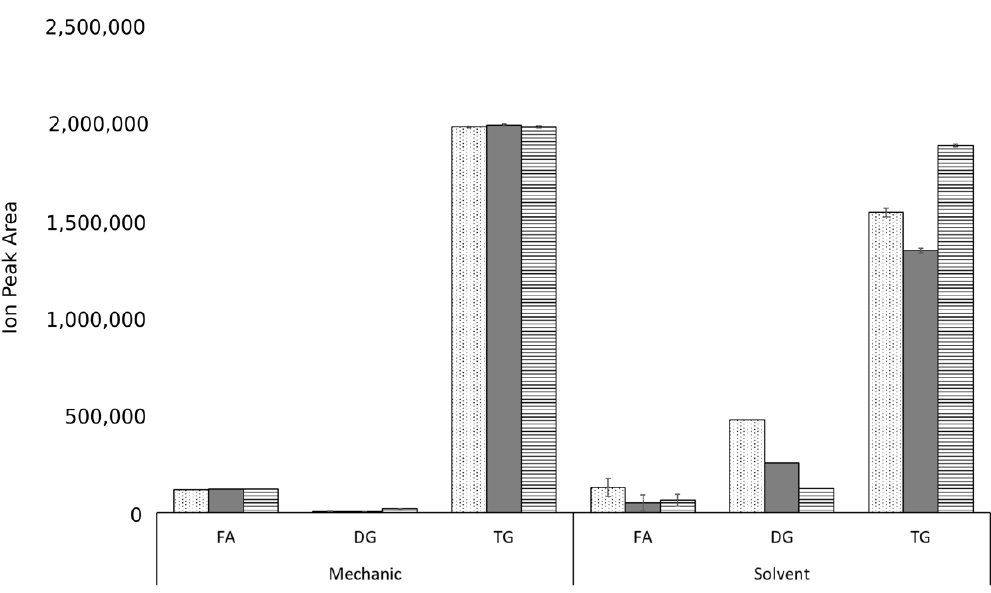
Figure 1. Comparison of the relative concentration of fatty acids (FA), diglycerides (DG), and triglycerides (TG) by method of extraction for açai (dotted bars), buriti (grey bars) and patawa (bars with horizontal lines) oils.